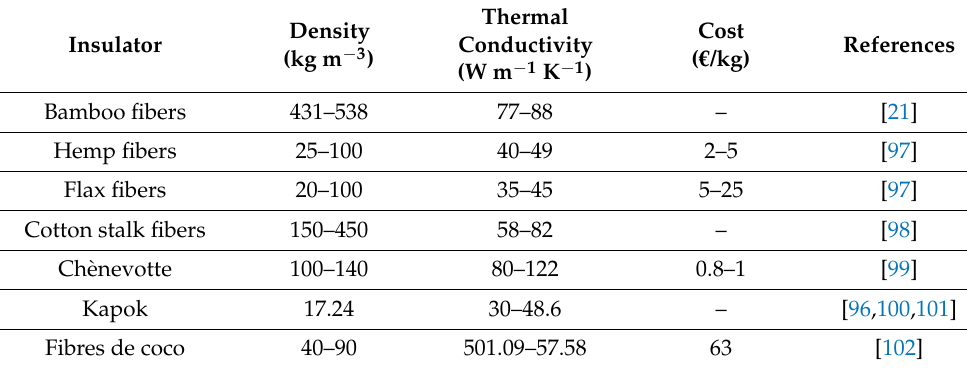
Table 5. Bio-sourced insulators considered in a future study as support materials for the fabrication of shape-stabilized PCMs.